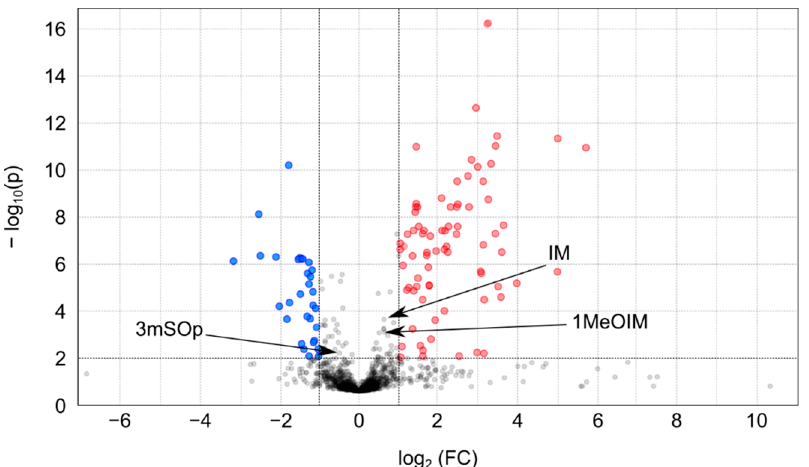
Figure 3. Volcano plot representing the detected features in the non-targeted metabolomic analysis. The y-axis represents the negative decade logarithm of the significance value ( FDR ) and the